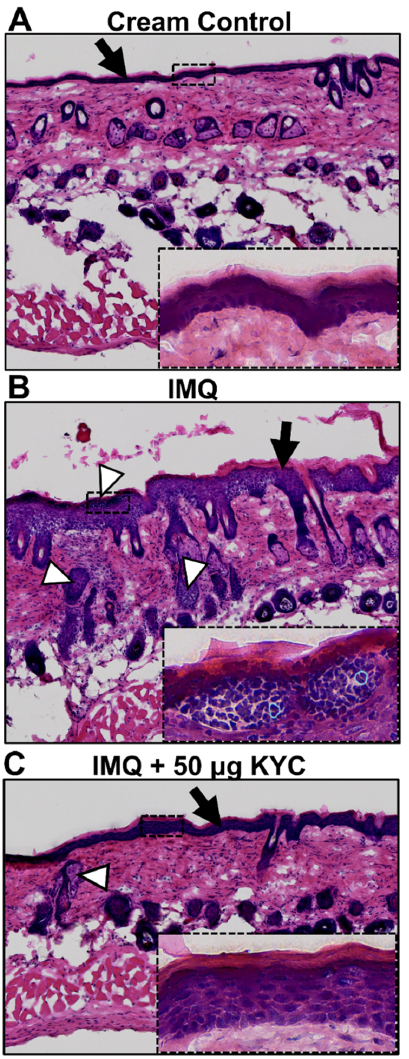
Figure 6. Skin histology during IMQ-induced skin inflammation and treated with KYC. Mice were administered IMQ or control cream daily for three days. Starting on day 1, KYC cream was given daily for two days. Skin sections were collected on day 3 at peak of disease, stained with H&E, and then assessed for overall signs of inflammation. Skin from a healthy, non-diseased mouse ( A ); psoriasis control mouse and ( B ) from a 50 µ g KYC cream-treated mouse ( C ) are shown. Black arrows indicate the epidermal layer; white arrowheads demarcate sites of immune infiltration into the dermis; blue outlines highlight example neutrophil borders. Images shown are representative of a single mouse per treatment